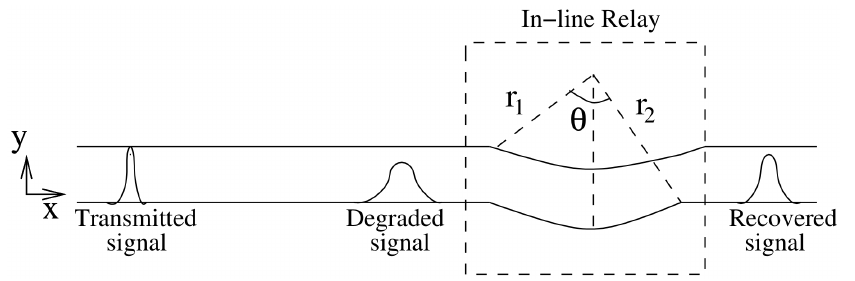
Figure 4. Concentration signal degrades as it traverses in straight microfluidic channel; inward turn of angle θ in the microfluidic channel restores the